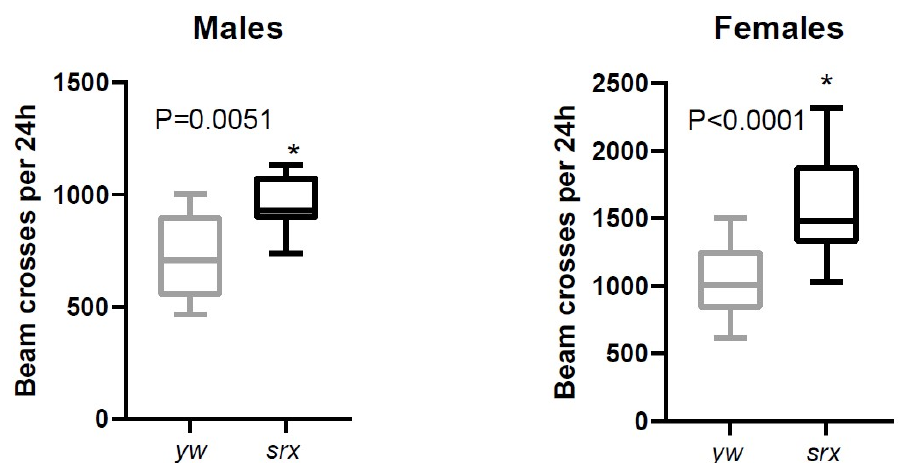
Figure 6. Effect of Srx underexpression on fly activity. The average activity of eight young (5 da) male and female flies was measured using the Trikinetics assay. The measurements were taken at 10 min intervals for five consecutive days. The data were obtained in two biological replicates. The average crosses of the beam per 24 h LD period are shown on the Y axis. Significance was analyzed by the t -test. Asterisks show statistically significant difference in activity between control ( yw ) and the srx mutant (srx). Representative activity data are shown in the graphs in Figure S7.